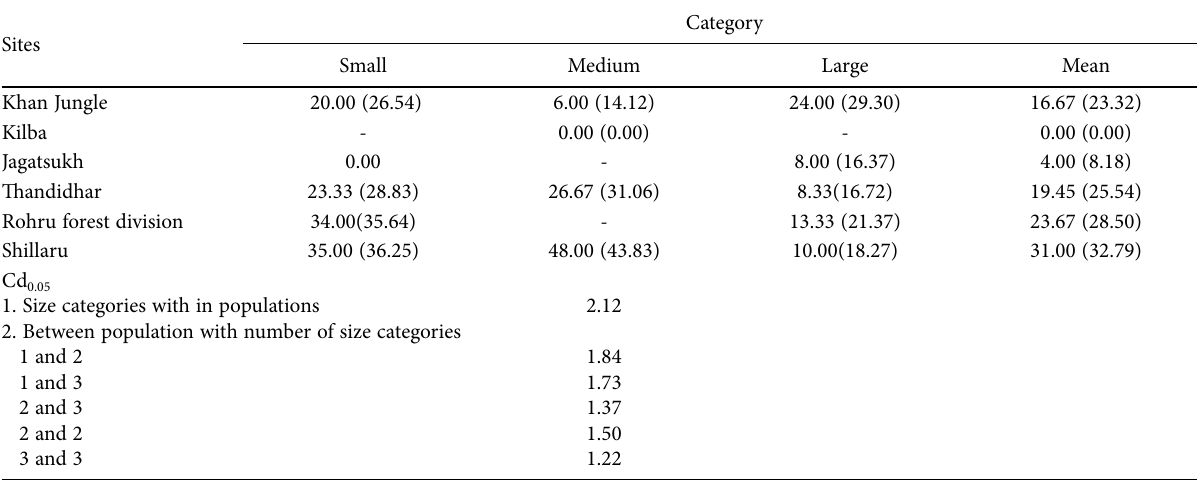
Values in parentheses are Arc Sine transformed values.